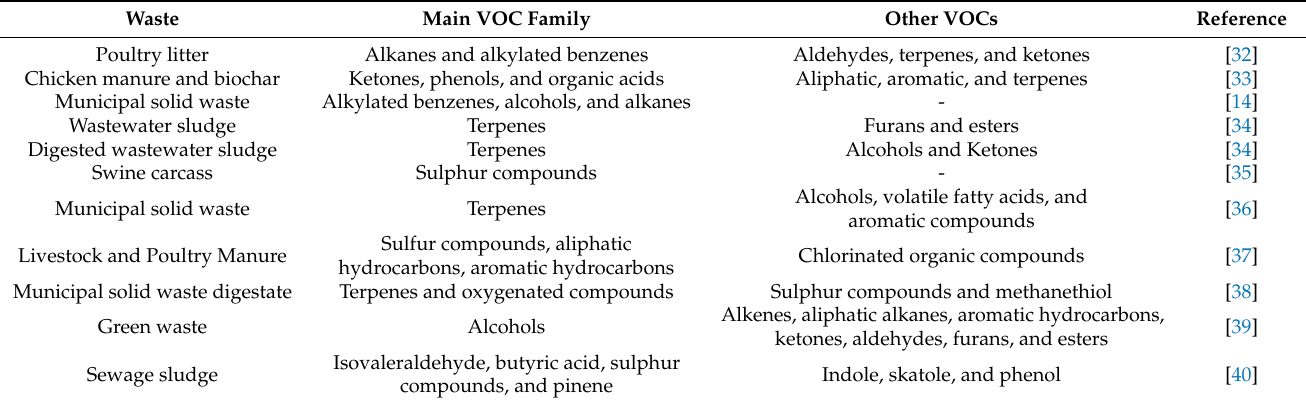
Table 1. Volatile organic compounds (VOCs) detected in the composting of different organic